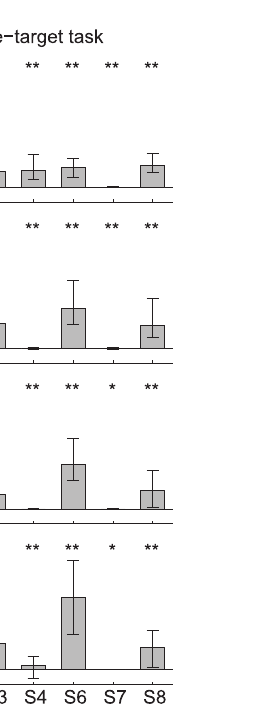
Figure 3. Model performance for the one-target task. Test error of standard model minus test error of extended model for all subjects and noise amplitudes. Values are given as the median over 100 cross- validation runs. The lower and upper error bars represent the 25 th and 75 th percentile, respectively. A positive value means that the extended model gave a better fit than the standard model. A value of zero means that there was no difference between the models. Conditions for which the extended model gave a significantly better prediction than the standard model are indicated by (cid:3) ( p v 0 : 05) or (cid:3)(cid:3) ( p v 0 : 01) . Subject S5 was discarded (see Methods